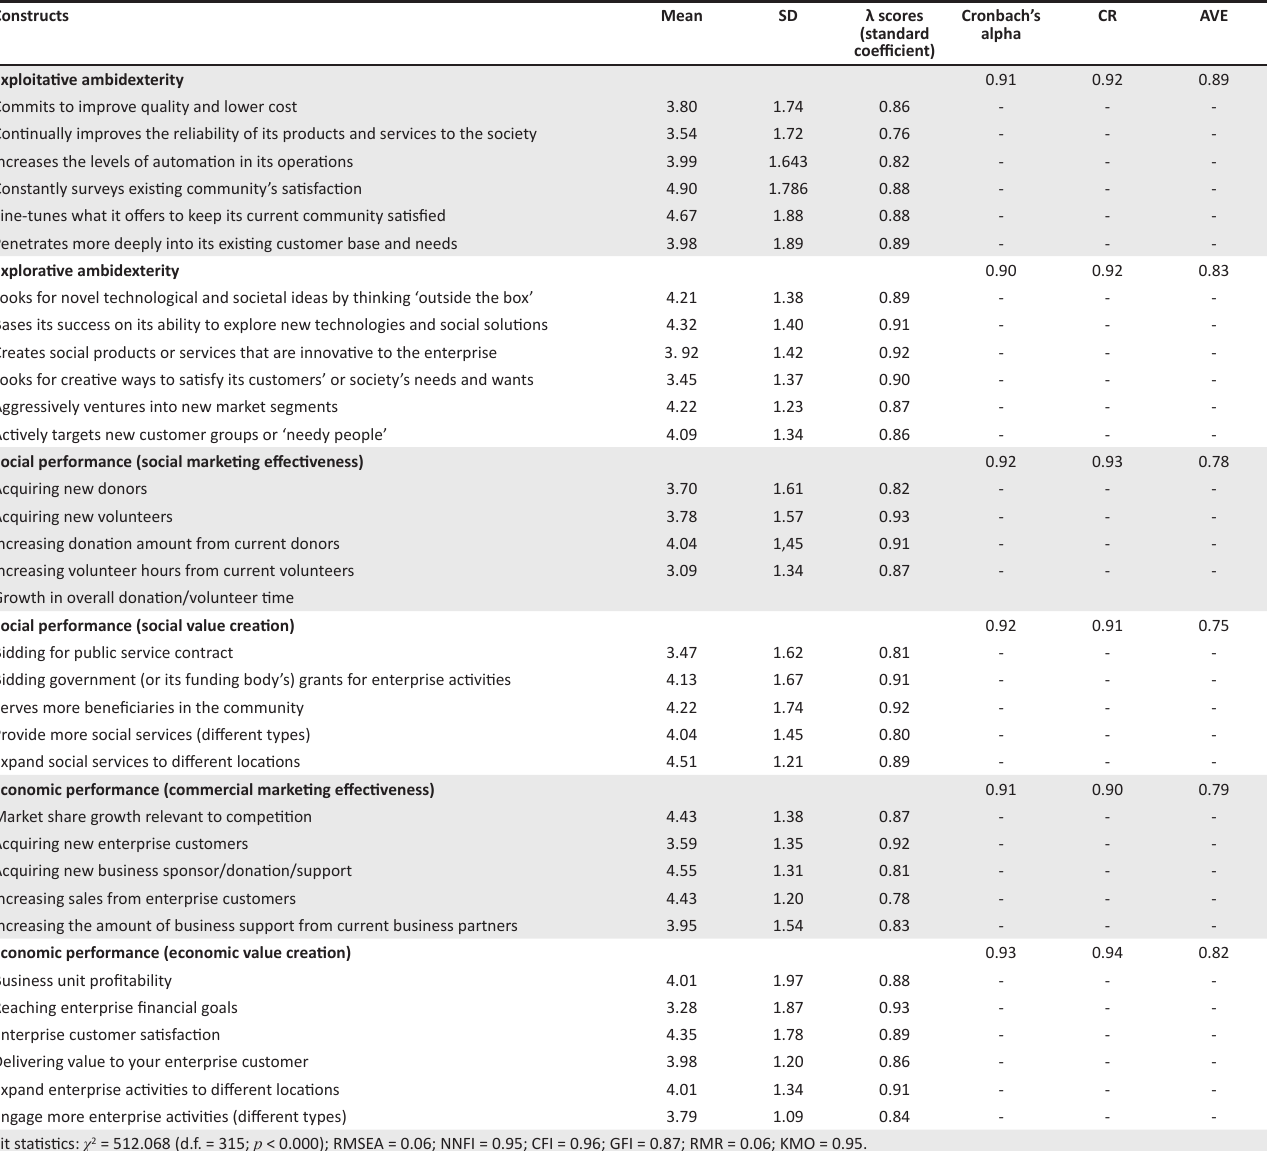
TABLE 1: Measurement validity and reliability.